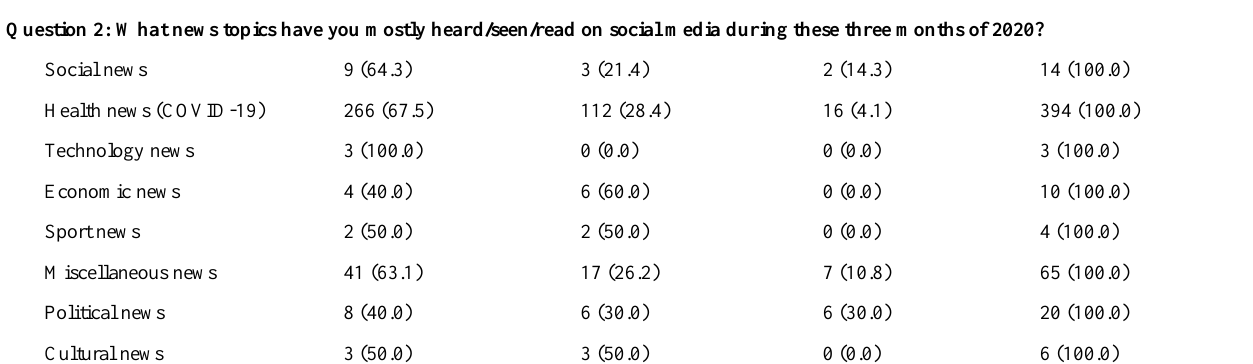
Table 10. Variable description by age and gender.